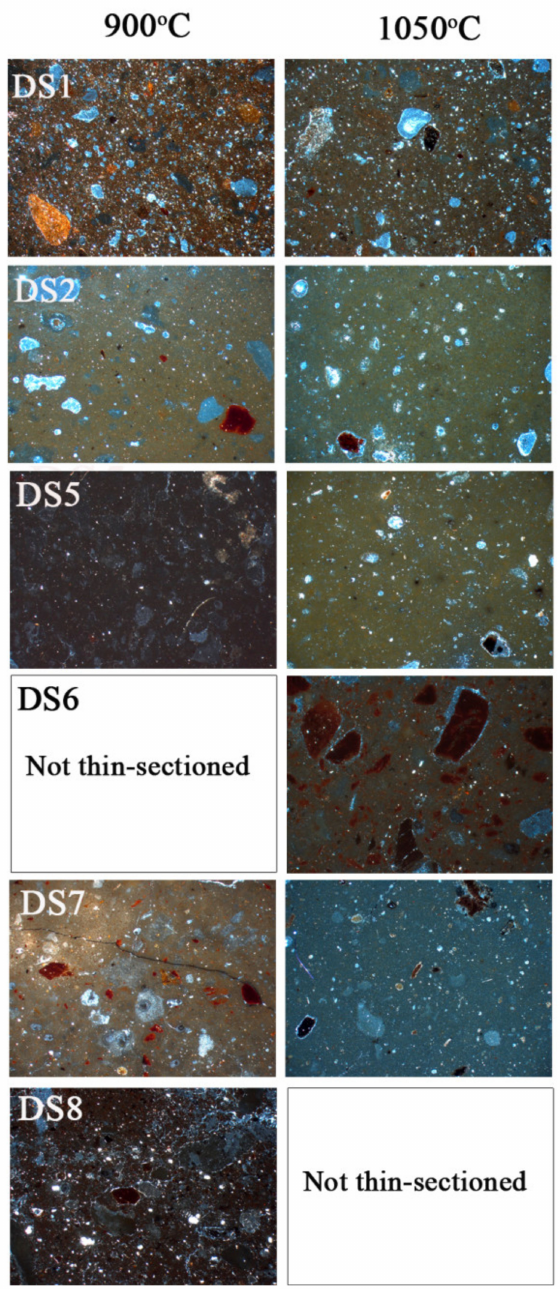
Figure 12. Photomicrographs of the thin sections made from the DS briquettes of the calcareous raw materials. All photomicrographs are taken under crossed Nicols (XP). (Width of field of view: 4.4